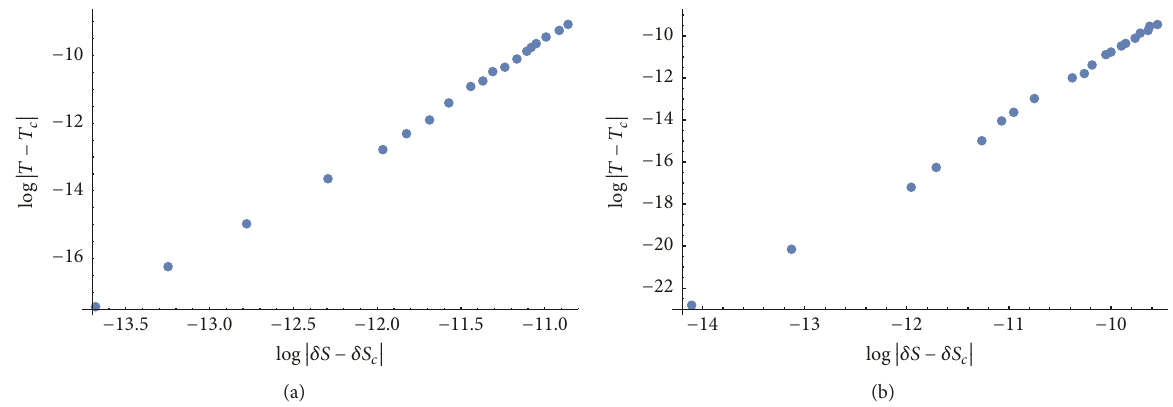
for the small scalar charge 𝑄 , there is always an unstable black hole thermodynamic system interpolating between the small stable black hole system and large stable black hole